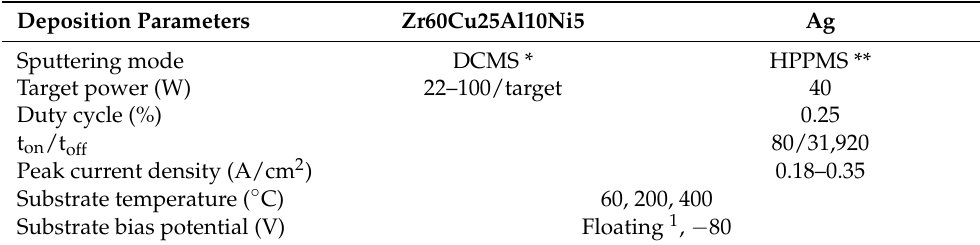
Table 1. Deposition parameters used to deposit the pure metallic glasses (MGs) and the Ag-containing thin films.